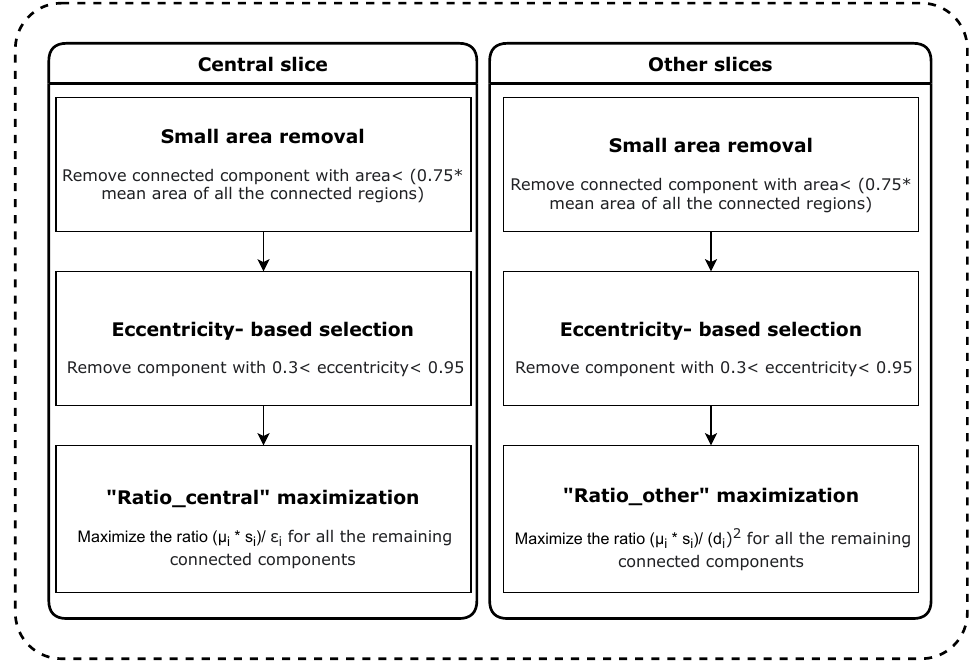
Figure 5. Diagram of the post-processing steps for both central slice and other